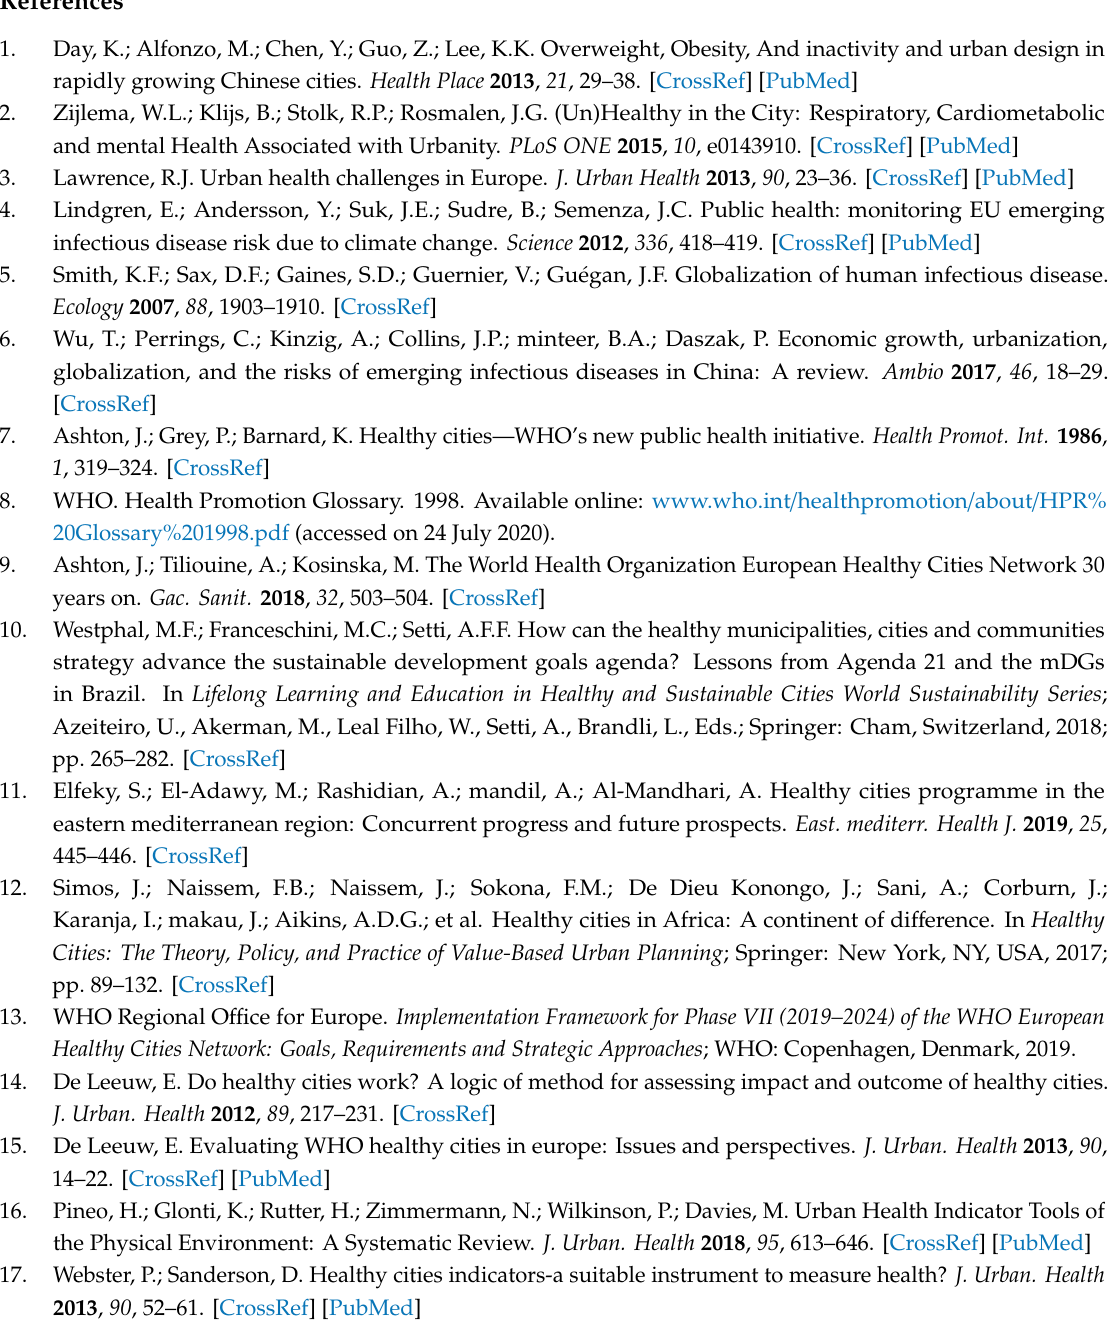
Figure S1: Indicators of transportation, Figure S2: Indicators of health service, Figure S3: Indicators of